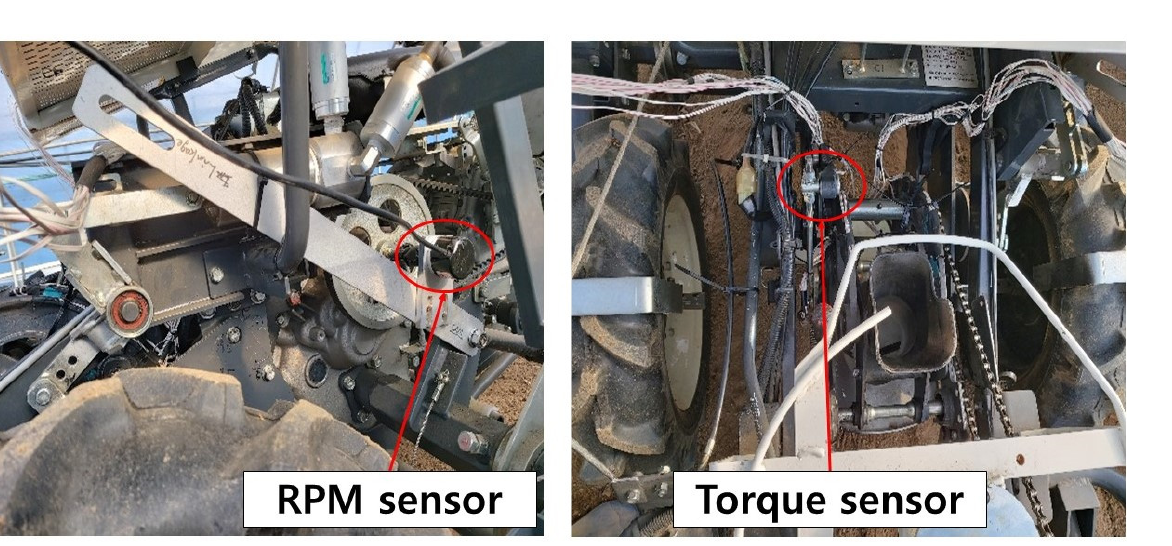
Figure 7. Location of torque and rpm sensor installed on four-bar-link vegetable transplanter. ( a )